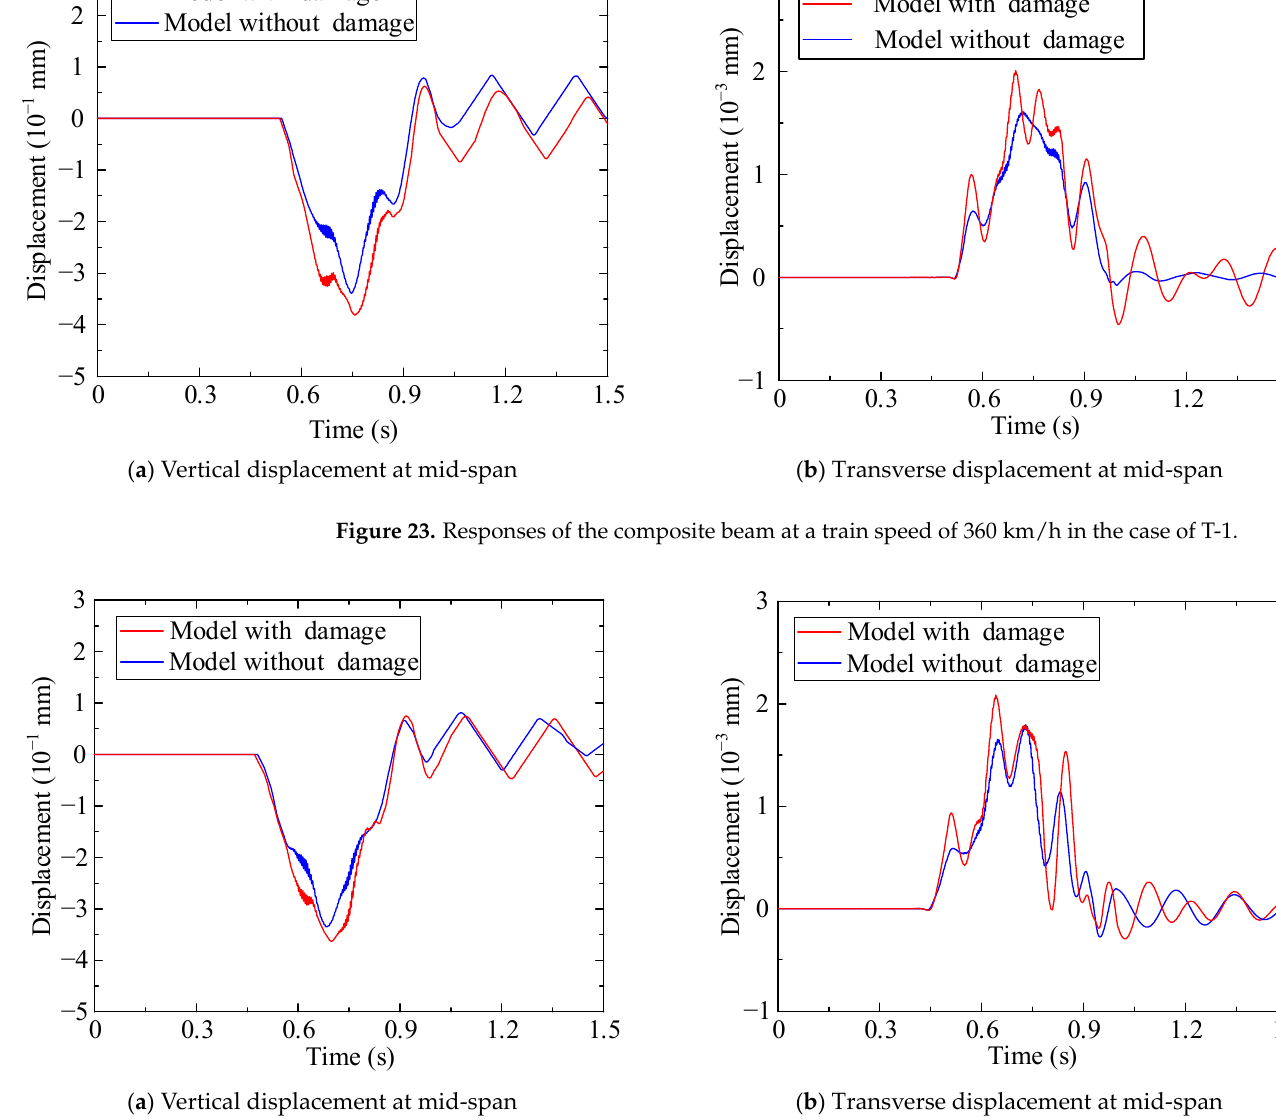
Figure 24. Responses of the composite beam at a train speed of 330 km/h in the case of T-1.